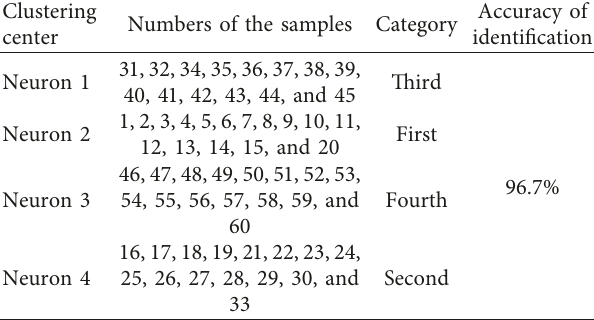
Figure 7: (a) Visualized clustering results and (b) weight distances between adjacent neurons of the water-adulterated salmon iden- tification model based on color moment features, texture features, and feature spectra. Table 4: Identification results.